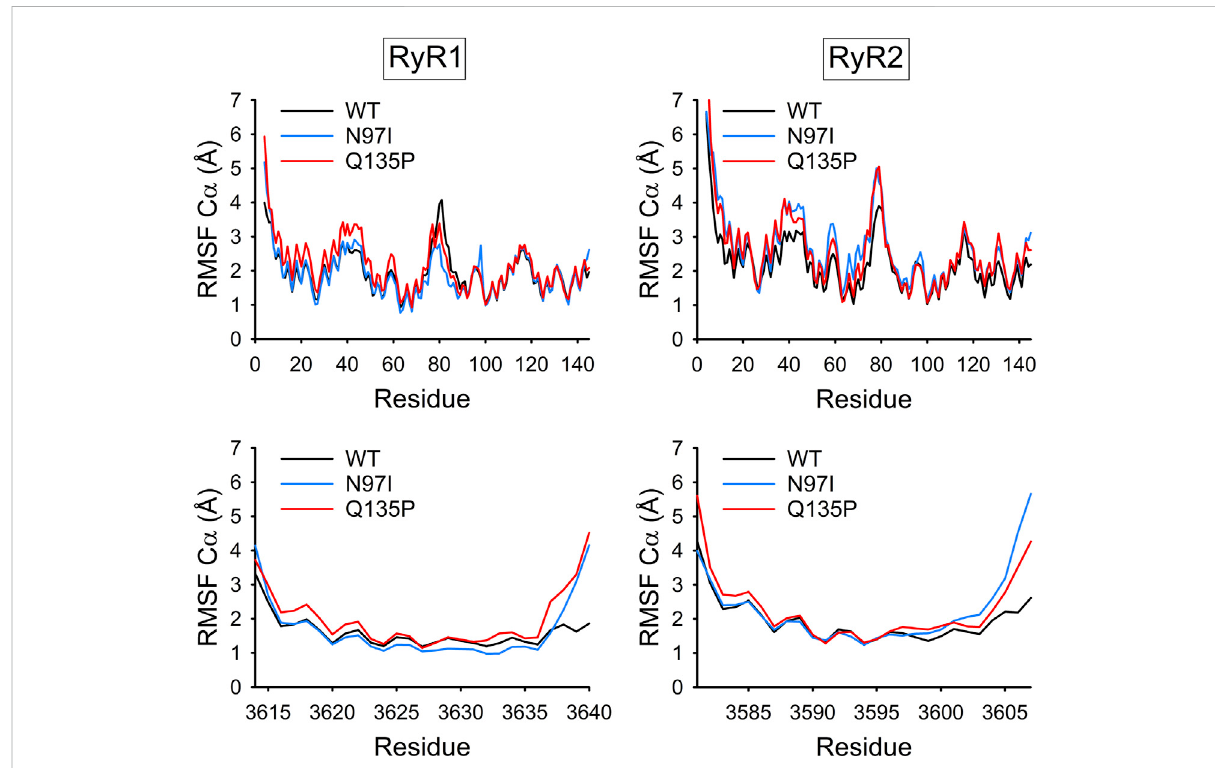
FIGURE 7 Backbone fl exibility of CaM-RyR1/2 complexes. C α -Root-Mean Square Fluctuation (RMSF) of CaM (top panels) and RyR1 or RyR2 peptides (bottom panels) calculated over 1.2 μ s MD simulations of the respective complex (WT: black, N97I: blue, and Q135P: